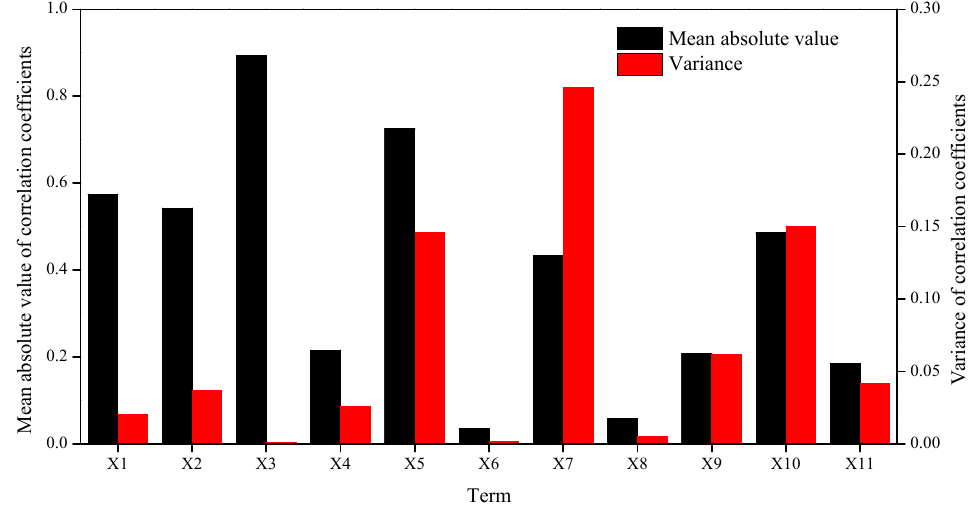
Figure 5. Mean absolute value and variance of correlation coefficients.